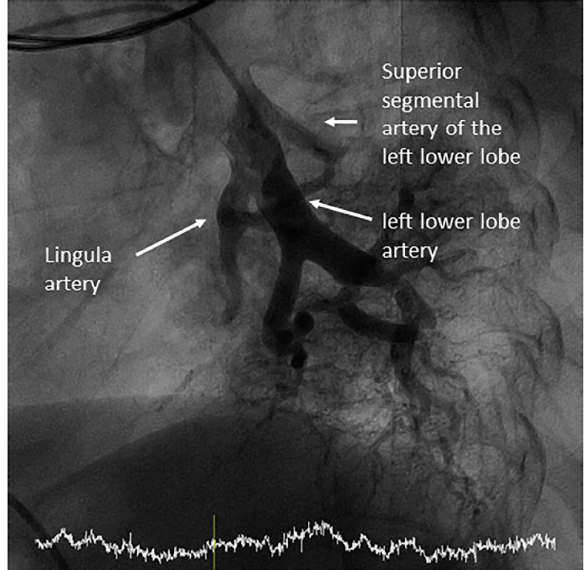
Figure 9. Right interlobar artery (( A , B ): anteroposterior view).